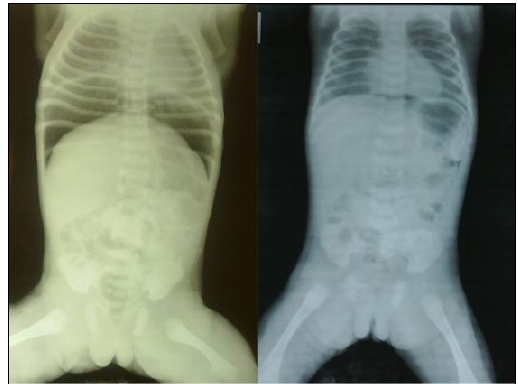
Figure 2: (a) Radiographs revealing the pneumoperitoneum (left). (b) Radiographs revealing resolution of spontaneous pneumoperitoneum after conservative management (right).